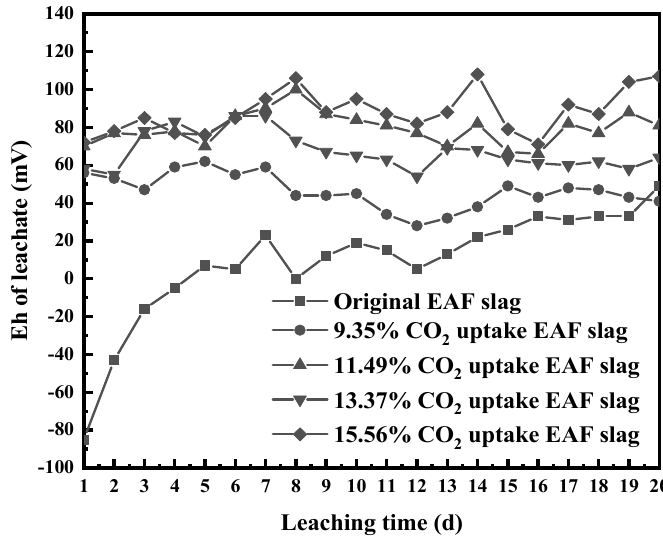
Figure 7. Evolution of leachates’ Eh as a function of leaching time. With the increase in carbonation depth, the Eh of the leachate gradually increased. With an uptake ratio of 15.56% CO 2 , the EAF slag leachate’s Eh fluctuated around 90 mV with the leaching time. The leachates of carbonated EAF slags were positive during the entire leaching cycle and did not undergo the process of changing from reduction to oxidization. The effect of carbonation on leachate’s Eh was mainly related to pH. When the dis- solved oxygen in the leachate was in equilibrium with the oxygen in the atmosphere, the oxidation-reduction potential can be calculated by the Equation (4) [25]: